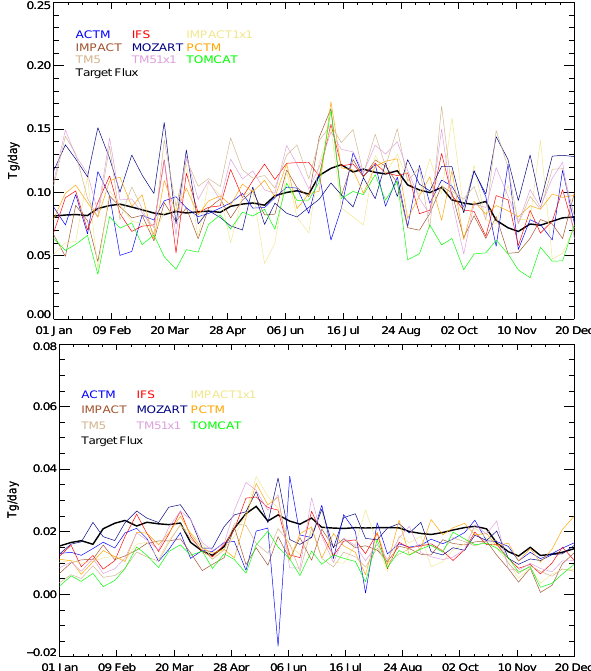
Fig. 11. Time series of weekly estimated CH 4 fluxes in Tg per day for Western Europe (top) and Oceania (bottom). The black line rep- resents the time series of the target